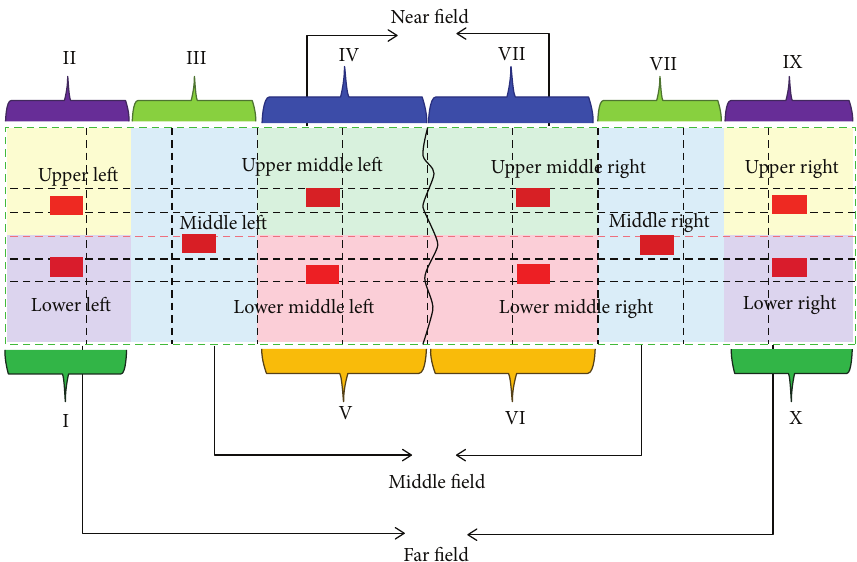
Figure 4: Setting of characteristic points in three.